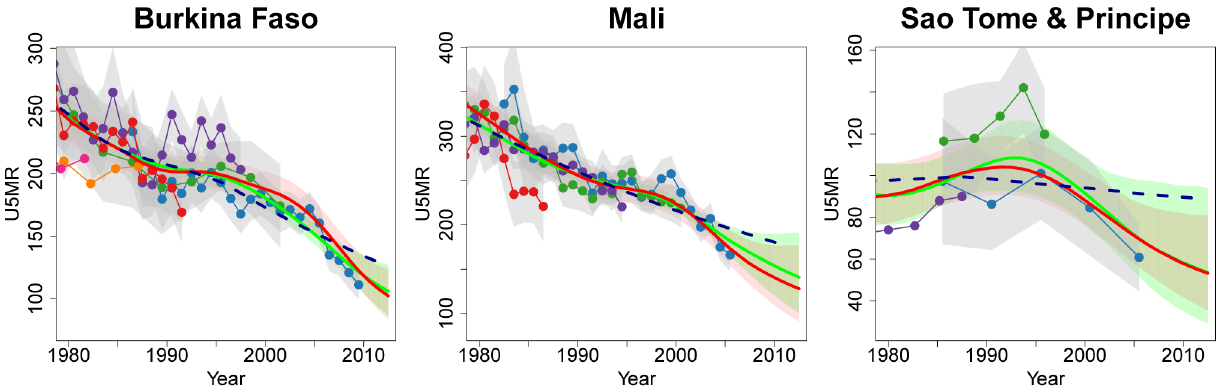
Figure 9. Comparison of U5MR estimates for Burkina Faso, Mali and Sao Tome and Principe where the change in curve fitting method changed the estimate by more than 10 deaths per 1,000 live births. Estimates compared are from UN IGME 2013 (solid red line with 90% credible intervals given by the shaded regions), B2 fit to 2013 database (solid light green line with 90% credible intervals given by the shaded regions), default Loess fit to 2013 database (dashed dark blue line). Connected dots denote data from the UN IGME 2013 database and gray shaded areas around series of observations represent the sampling variability in the series (quantified by two times of the sampling standard errors). Excluded data series and detailed information on all data series are displayed in Figure S1.